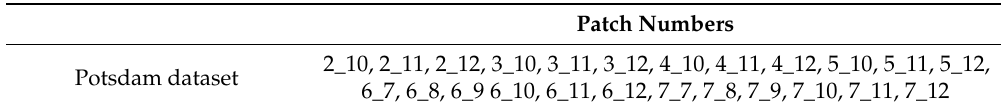
Figure 3. Example of the International Society for Photogrammetry and Remote Sensing (ISPRS) dataset; the patch number is 2–10: ( a ) RGB-image, ( b ) labeling image, ( c ) enlarged RGB-image, and ( d ) data labels. Table 1. Patch numbers of labeled data.